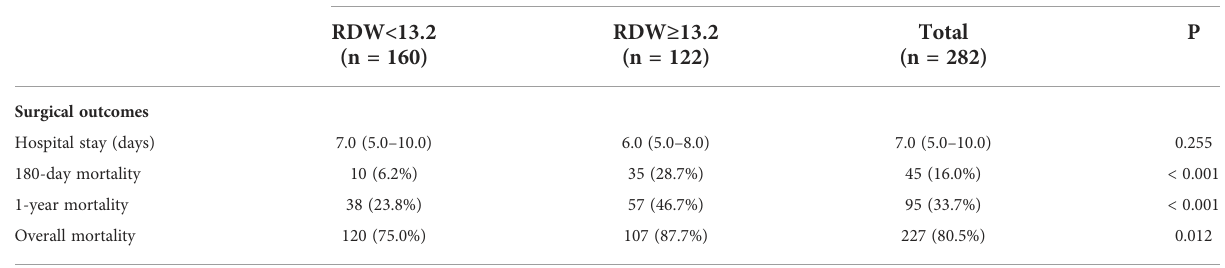
TABLE 2 Surgical outcomes of study